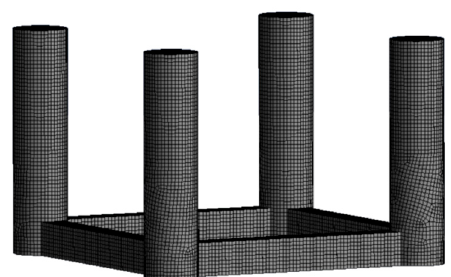
Figure 5. Diagram of grid division.